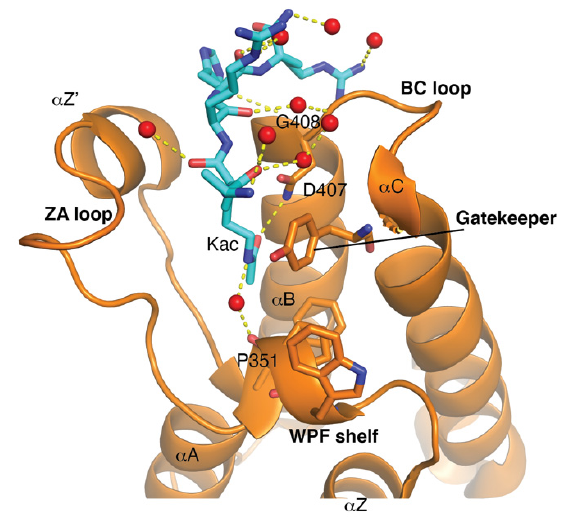
Figure 1. Structural features of the bromodomain binding pocket. The general control non-depressible 5 protein (Gcn5p) bromodomain (orange) is shown in complex with an acetylated histone H4 peptide (cyan) (PDB ID: 1E6I). Hydrogen bonds are indicated by a yellow dotted line, and water is colored in red. This figure was generated with the PyMOL Molecular Graphics System, version 2.4.2, Schrödinger, LLC.